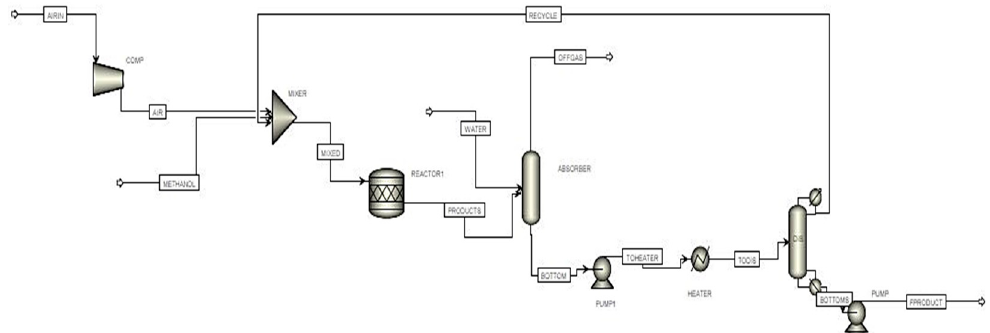
Figure 2. Simulation model of silver-based formaldehyde process.